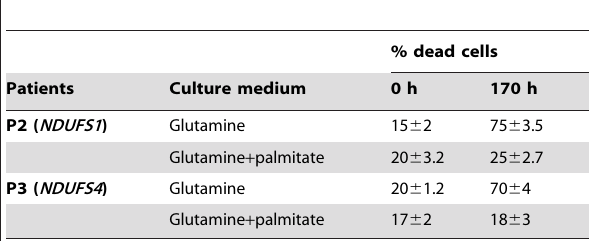
comparison A and B) only losing 9 points/month on average: